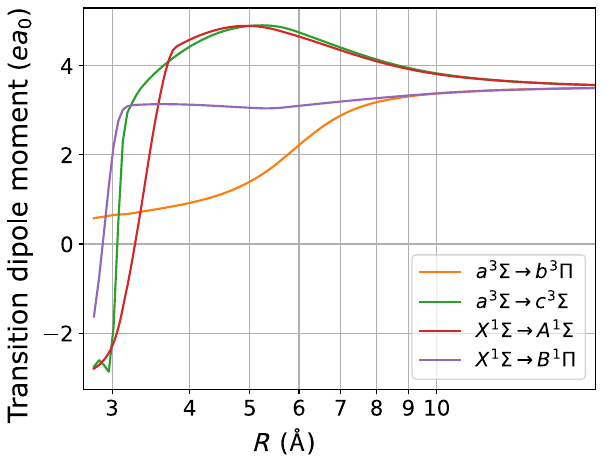
FIG. 6. Electronic transition dipole moments calculated via ab initio methods between different electronic states of NaCs. These transition dipole moments are shown in units of ea 0 , where e is the elementary charge and a 0 is the Bohr radius. They are plotted as a function of internuclear distance R